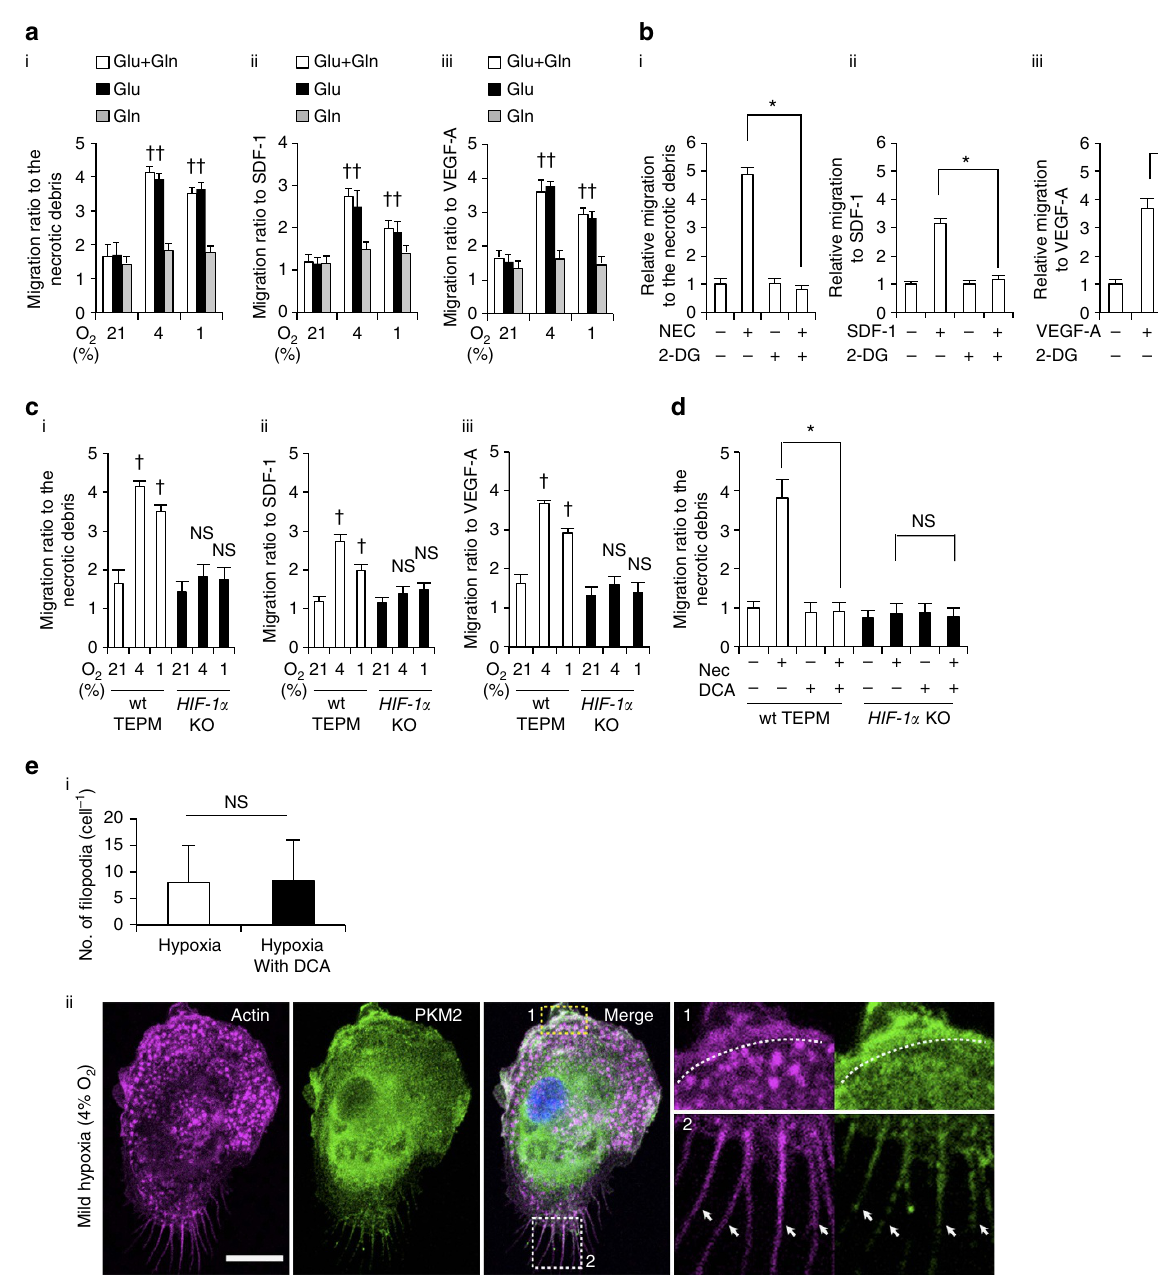
Figure 4 | The role of glycolytic reprogramming in macrophage migratory capacity in vitro . ( a ) (i-iii) Macrophage migration activity to various chemoattractants (the supernatant of necrotic cell debris (i), stromal cell-derived factor 1 (SDF-1; 100ngml (cid:2) 1 ; ii) and VEGF-A (100ngml (cid:2) 1 ; iii)) was measured by transwell assay in normoxia (21% O 2 , 4h), mild hypoxia (4% O 2 , 4h) and severe hypoxia (1% O 2 , 4h). The culture mediums were supplemented with 10mM glucose (Glu) only, 2mM L-glutamine (Gln) only or both. The y axis represents the migration activity relative to untreated condition. n ¼ 3 animals. ( b ) Macrophage migration activity was measured in mild hypoxia in the presence of 2-DG (20mM). n ¼ 3 animals. ( c ) Migration activity in wild-type and HIF-1 a -deficient macrophages was measured in the same manner as 4 ( a ). n ¼ 3 animals per group. ( d ) Macrophage migration activity to the supernatant of necrotic cell debris was measured in mild hypoxia in the presence of DCA (10mM). n ¼ 3 animals per group. ( e ) (i) The number of filopodia in TEPMs is shown. TEPMs were cultured under mild hypoxia in the presence or absence of DCA (10mM). (average with s.d. n ¼ 100 cells analysed). (ii) Representative immunocytochemical staining of Hoechst (blue), PKM2 (green) and Phalloidin (magenta) in TEPMs under mild hypoxia is shown. F-actin and PKM2 were co-localized in lamellipodia (magnified view 1, dotted line) and filopodia (magnified view 2, arrowheads). Scale bars, 10 m m. All graphs indicate average with s.d.. Student’s t -test was performed to calculate P value. * P o 0.05; NS, not significant; w P o 0.05 versus control (21% O 2 ); 2-DG, 2-Deoxy- D -glucose; NEC, the supernatant of necrotic cell